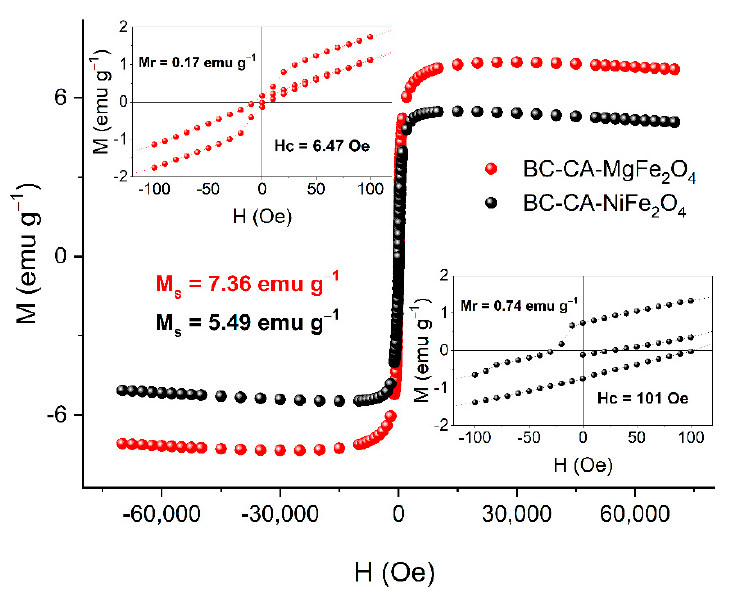
Figure 4. Magnetic hysteresis loop for BC-CA-MgFe 2 O 4 ( ● ) and BC-CA-NiFe 2 O 4 ( ● ) of bacterial cellulose magnetic composites.